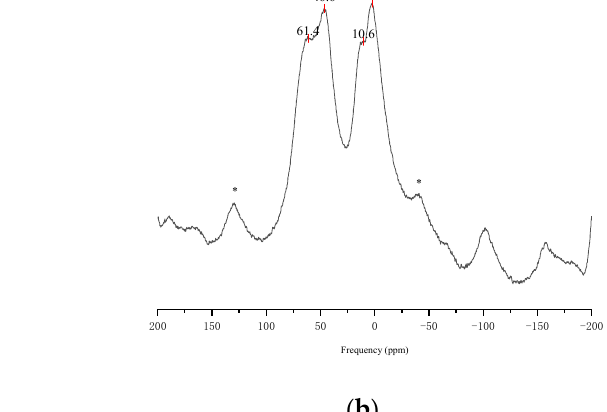
Figure 7. XRD of ordinary kaolin ( a ), metakaolin ( b ) and alkali-activated metakaolin ( c ). On the NMR of metakaolin, peaks were found at 61.4, 46.6, 10.6 and 2.5 ppm (Figure